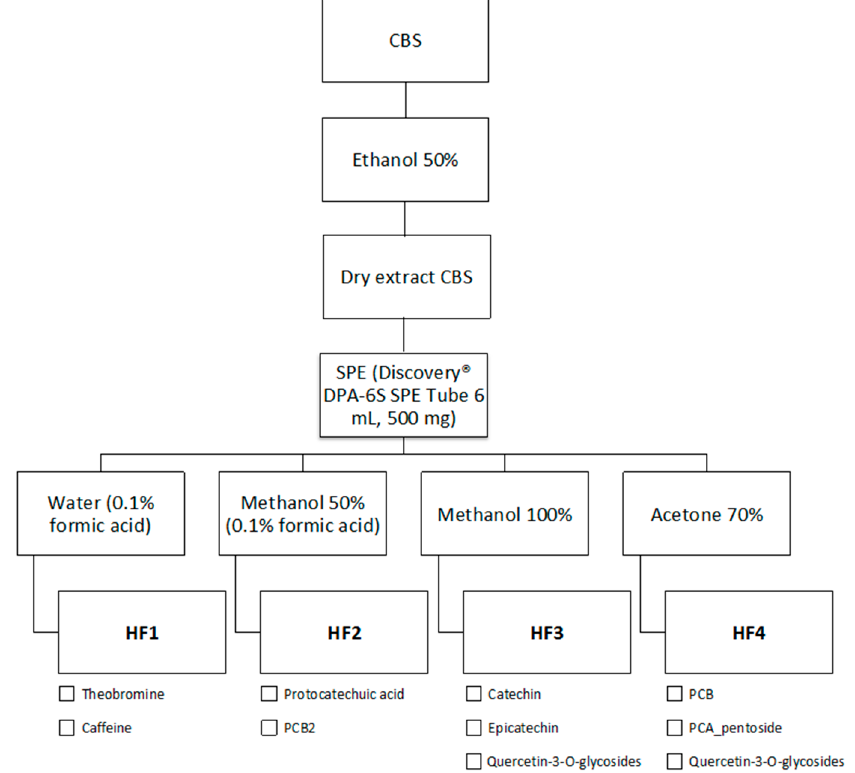
Scheme 1. Schematic representation of the extraction and purification procedures to yield the cocoa bean shell (CBS) bioactive compounds. HF1–4: Honduras-Fraction 1–4; PCB: procyanidin B type;